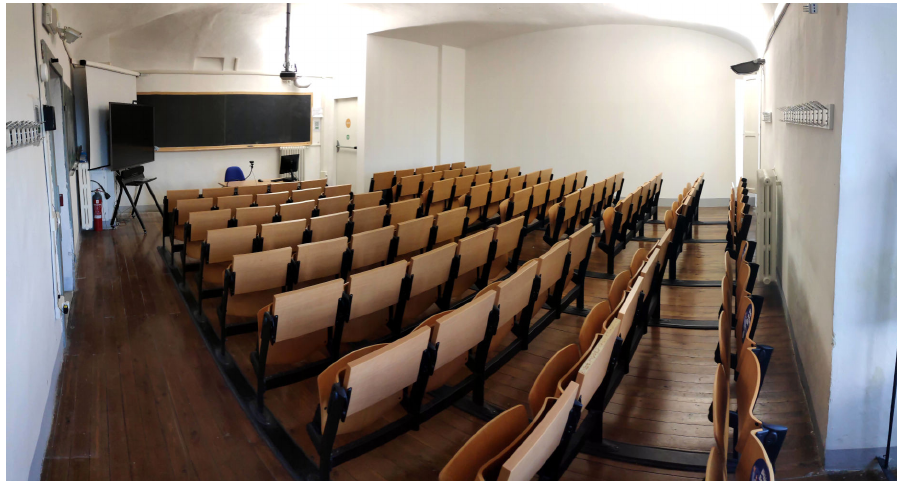
Figure 8. A picture of the examined university